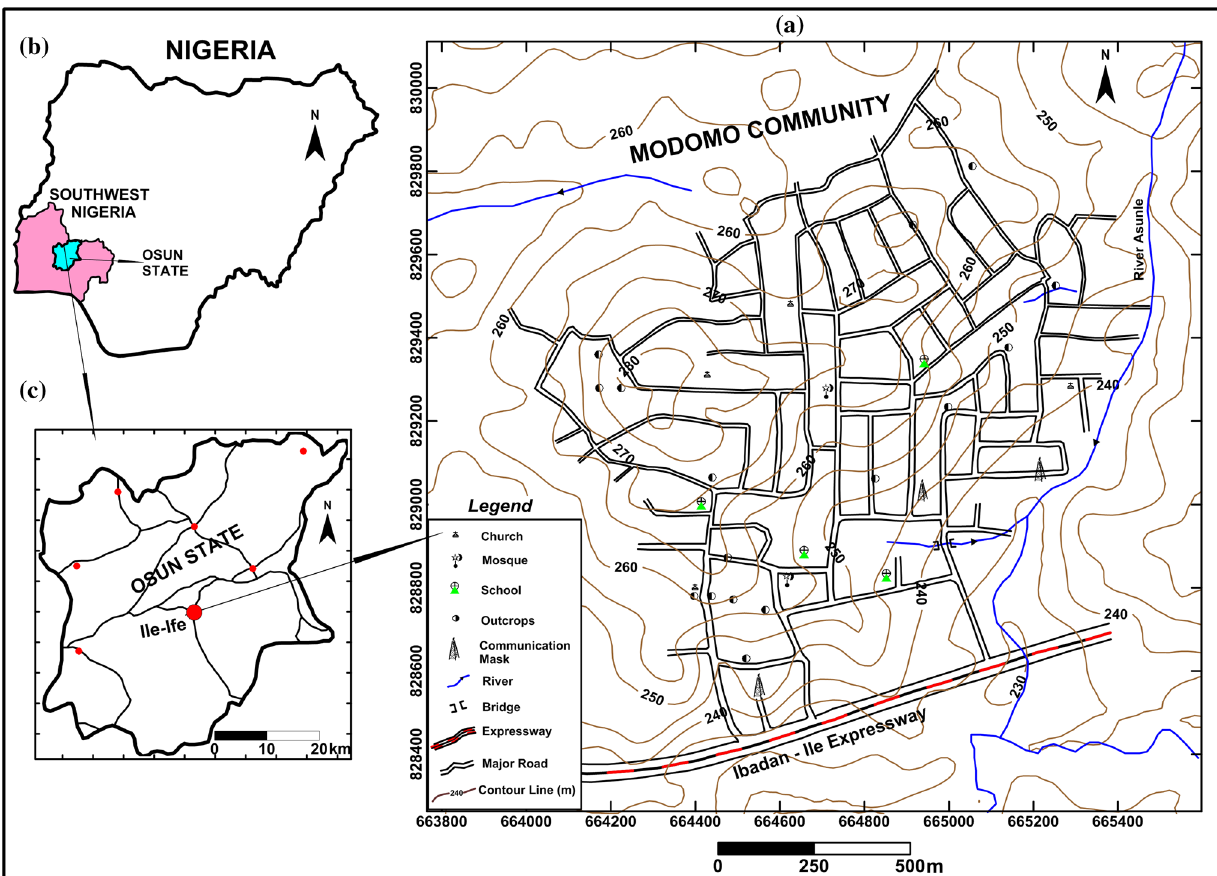
Fig. 1 Location map of a the study area b Nigeria showing Southwestern Region and Osun State and c Osun State showing